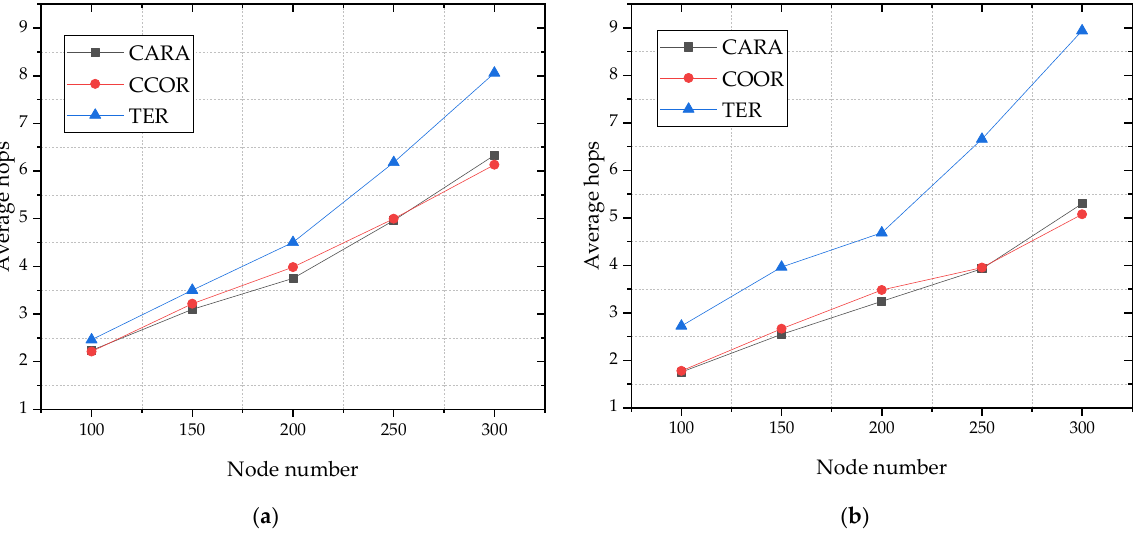
Figure 4. The average hops with the number of nodes. ( a ) Cache queue lengths = 20; ( b ) cache queue lengths = 30.